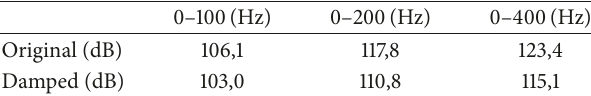
Table 3: Overall value of the FRFs for door